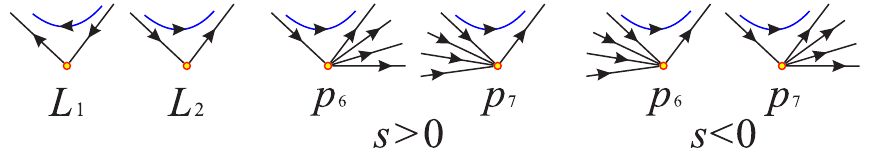
Figure 12. There are six kinds of equilibrium points on the hyperbola 2 z 1 ( z 1 − z 2 ) =